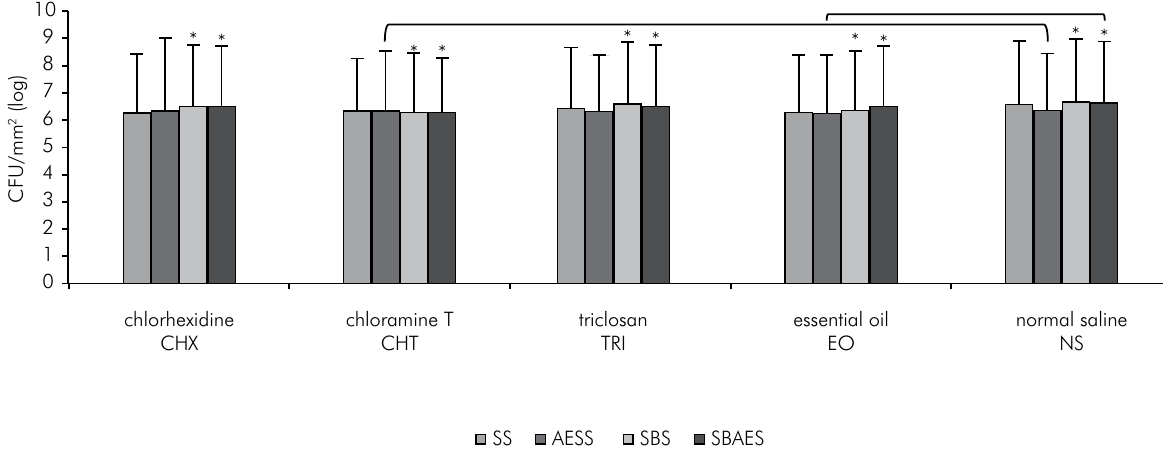
Figure. Average bacterial counts (SE) considering antiseptic treatments and titanium